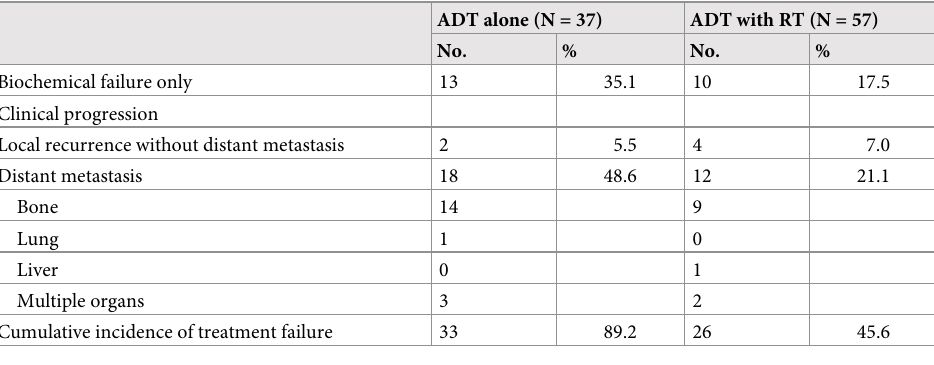
Abbreviations: ADT, androgen deprivation therapy; RT, radiotherapy.